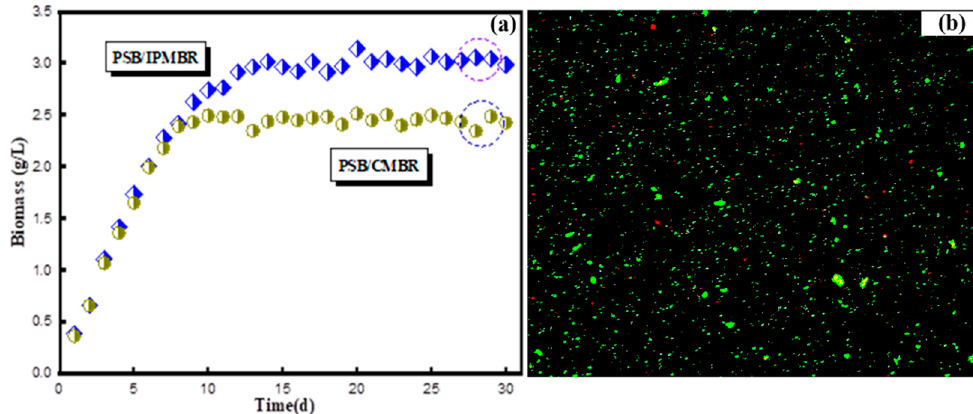
Figure 5. ( a ) Biomass productivity of the suspended and encapsulated system with operation time increasing. ( b ) Inverted fluorescence microscope photograph of the PSB-encapsulated hydrogel macrosphere.